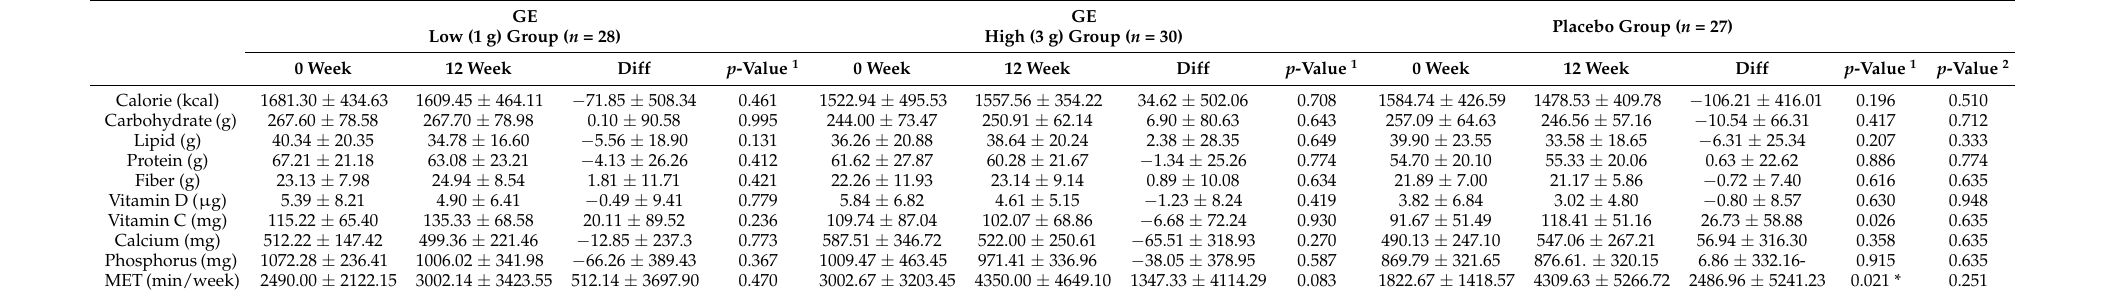
Table 3. Nutrient intakes of the study subjects during the 12-week intervention period.